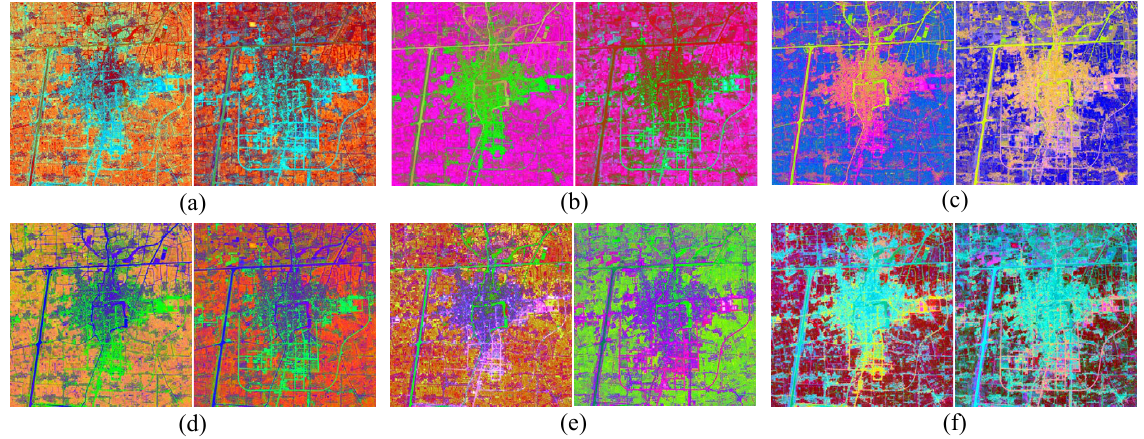
Figure 7. Bi-temporal pseudo color images of projection features by performing: ( a ) DSFA-64-2, ( b ) DSFA-128-2, ( c ) DSFA-256-2, ( d ) ADM-D-PRNs using USFA, ( e ) ADM-D-PRNs using IRMAD, and ( f ) ADM-D-PRNs using PCA, on dataset ‘Taizhou’.